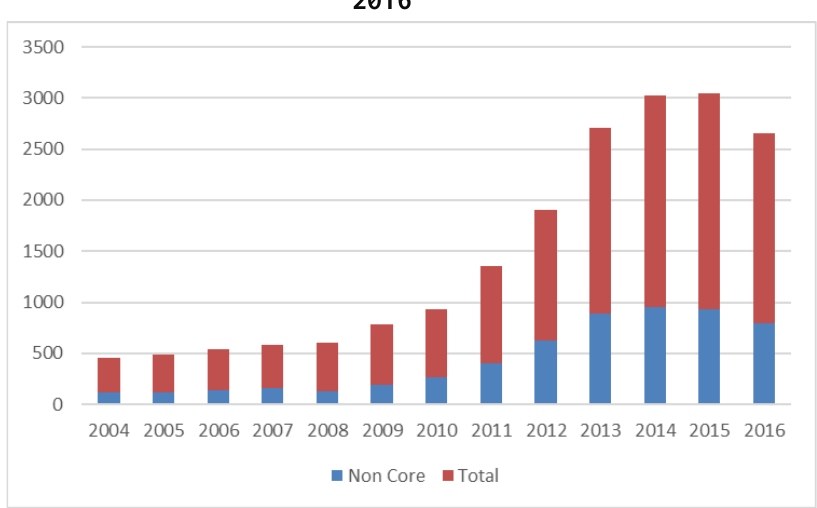
Figure 4: Home Nations of International Secondary Students in the United States, 2004-